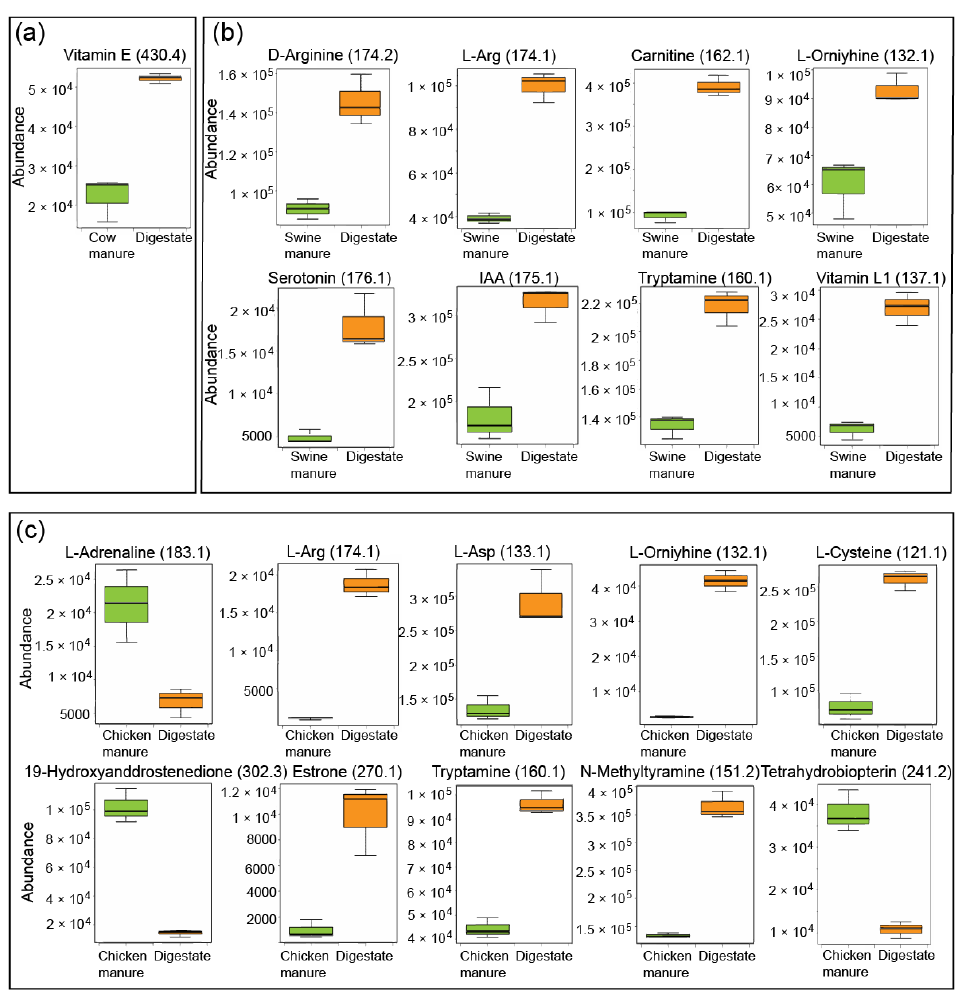
Figure 4. Comparison of the relative content of bioactive compounds; ( a ) cow manure and digestate, ( b ) swine manure and digestate, ( c ) chicken manure and digestate.